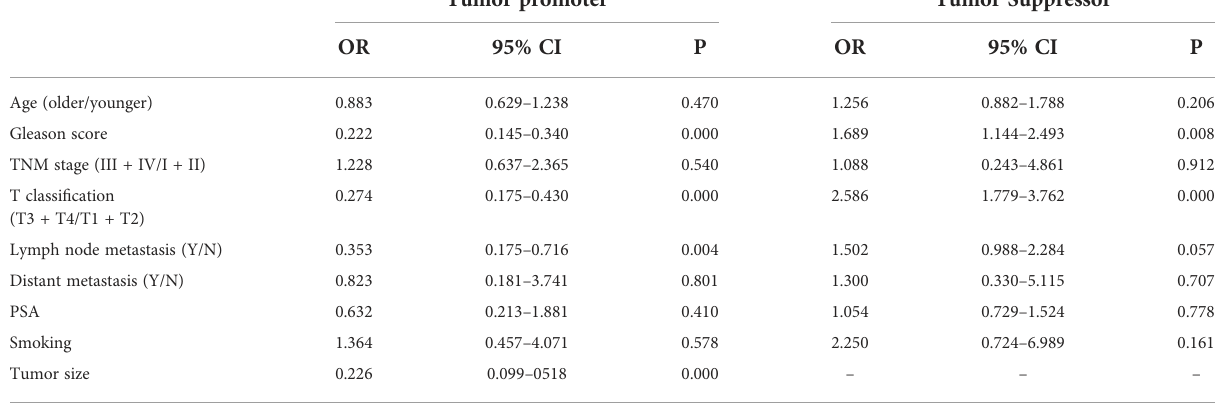
TABLE 2 Clinical parameters of circRNAs in